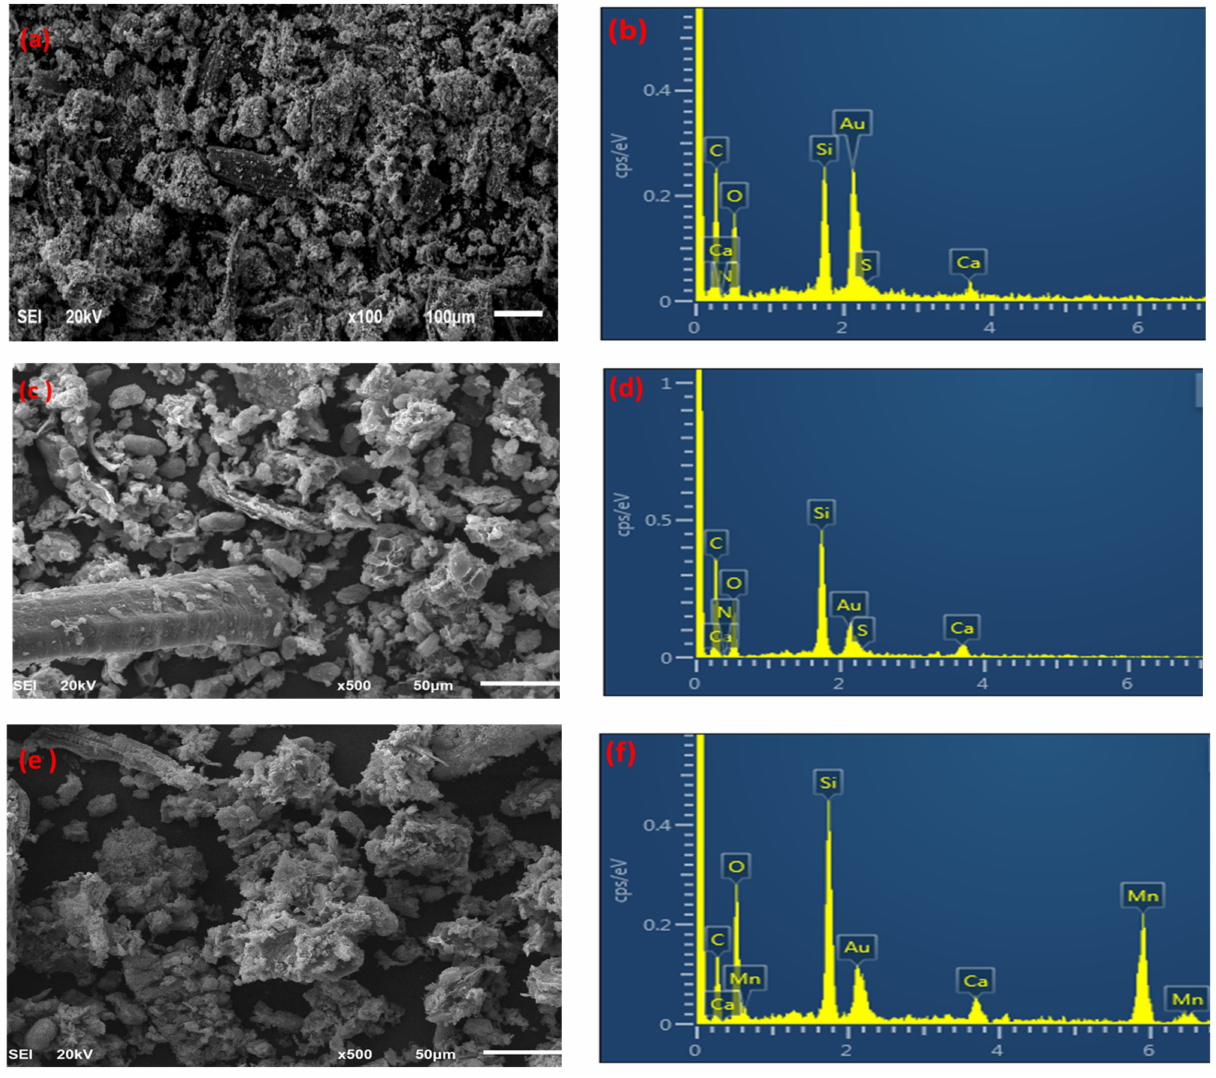
Figure 2. SEM and EDX for palm waste ( a , b ), biochar ( c , d ), and MnO 2 /PF biochar ( e , f